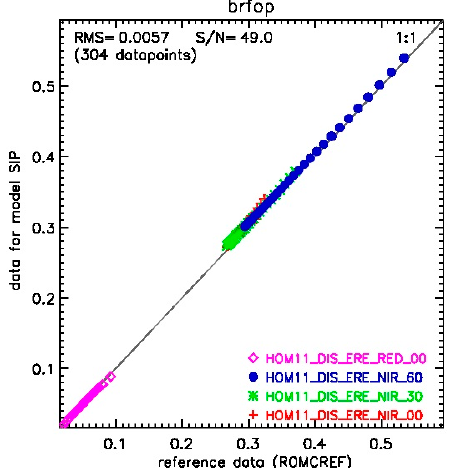
Figure 3. The scatter plots between the BRF of the SIP simulations and the RAMI reference values (ROMCREF) in the red and NIR bands in the orthogonal plane at the RAMI platform in Figure 2. The root mean square (RMS) error and signal-to-noise (S/N) were directly calculated with the RAMI platform (http://romc.jrc.ec.europa.eu/).